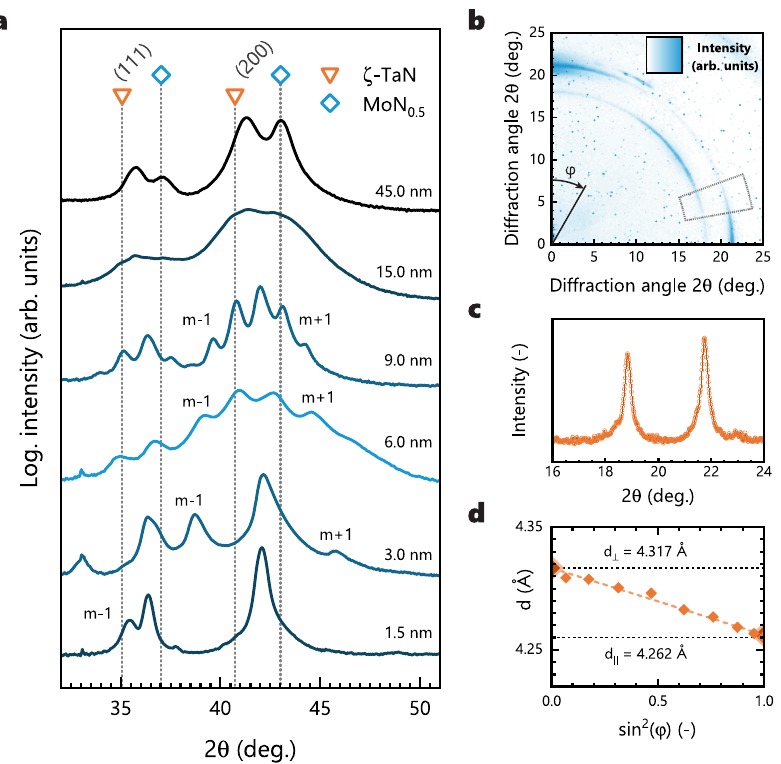
Fig. 4 X-ray diffraction analysis. X-ray diffraction patterns in ( a ) of our superlattice thin fi lms. The labeling (m + 1) and (m-1) mark the satellite peaks stemming from the layered structure of our coatings. The bilayer periods quoted on the right side of a are the nominal ones. The intensity plot in ( b ) shows a quarter of a Debye – Scherrer pattern recorded in transmission geometry (sample thickness in beam direction was ~50 μ m) at the nanofocus endstation at the beamline P03 of PETRAIII at Deutsches Elektronen-Synchrotron (DESY). The gray marked area was integrated in φ direction and plotted in ( c ). The plot in ( d ) shows derived lattice parameters over sin 2 ( φ ) and the corresponding linear fi t.